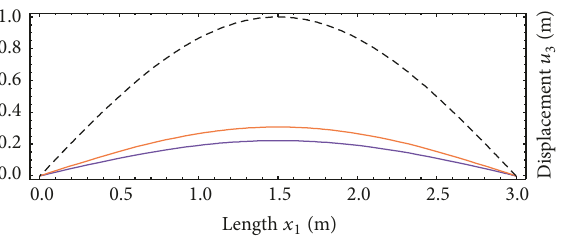
Figure 4: The cross section that contains the center of the micropolar square plate 2.0 m × 2.0 m × 0.1m made of polyurethane foam under the sinusoidal load: Cosserat clamped plate, solid blue line, Cosserat simply supported plate, solid orange line, and initial sinusoidal load, dashed black line.